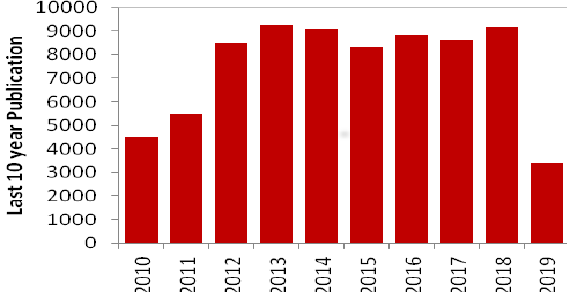
Figure 2. Number of Wireless Sensor Network based article publications by the year.